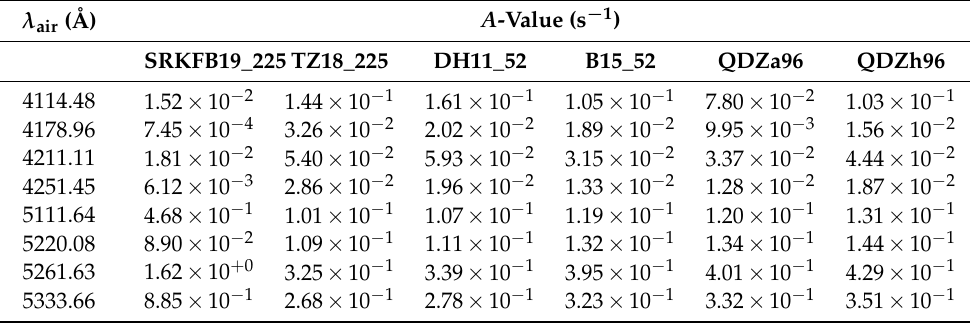
Table 7. A -values for transitions arising from the 3d 6 4s a 4 H J and 3d 6 4s b 2 H J levels ( J = 9/2 and 11/2) upper levels of [Fe II ] listed in different atom datasets, which show the large discrepancies in